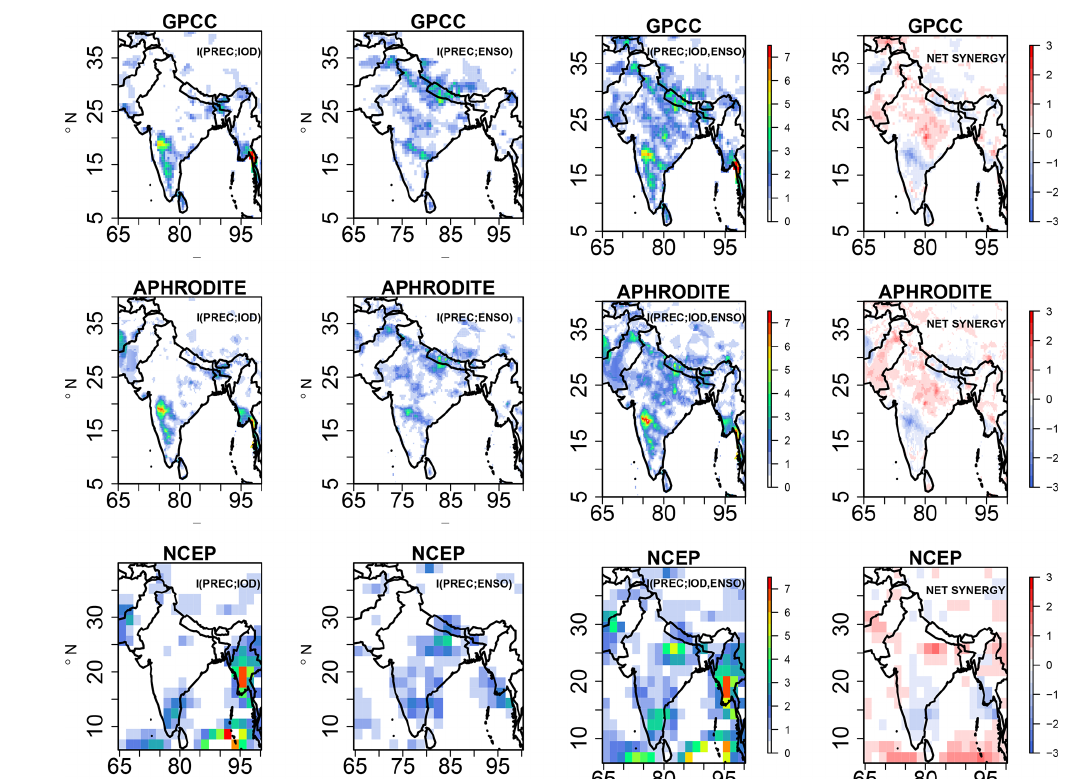
Figure 5. Information exchange from I (PREC; IOD), I (PREC; ENSO), two-source information exchange I (PREC; ENSO, IOD), and net synergy × 10 − 2 nats for the observational datasets GPCC, APHRODITE, and NCEP reanalysis. Only significant values at 95% confidence intervals are